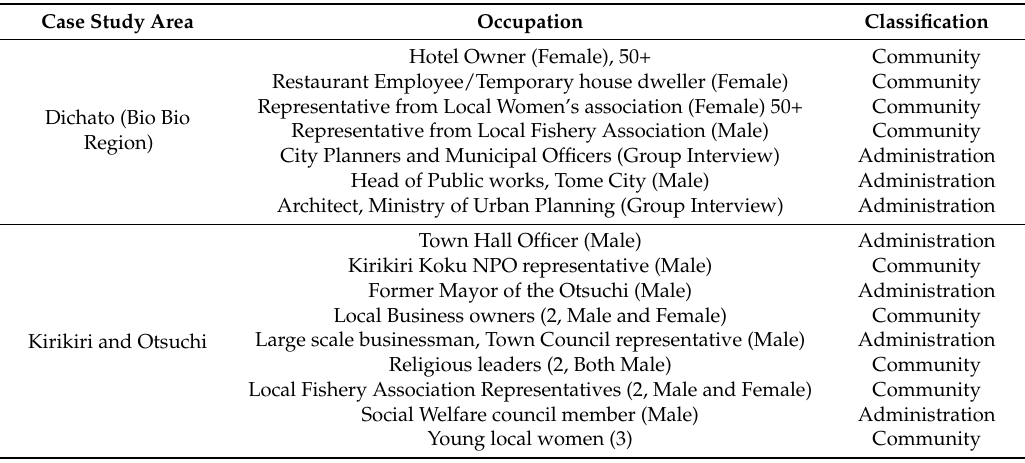
Figure 3. Key informant interviews were carried out in Chile [Photo ( a ), ( b ), ( c )] and Japan [Photo ( d ), ( e ), ( f )], involving ( a ) an architect working at the Ministry of Urban Planning, ( b ) a representative from the Local Fishery Association of the Bio Bio Region, ( c ) a representative from the Local Women’s association of the Bio Bio Region, ( d ) a member of Otsuchi town council, ( e ) the director of the women’s group of Kirikiri fishery and fishermen, and ( f ) junior and high school girls in Otsuchi city. Table 2. Details of key informant interviews for both Chile and Japan.